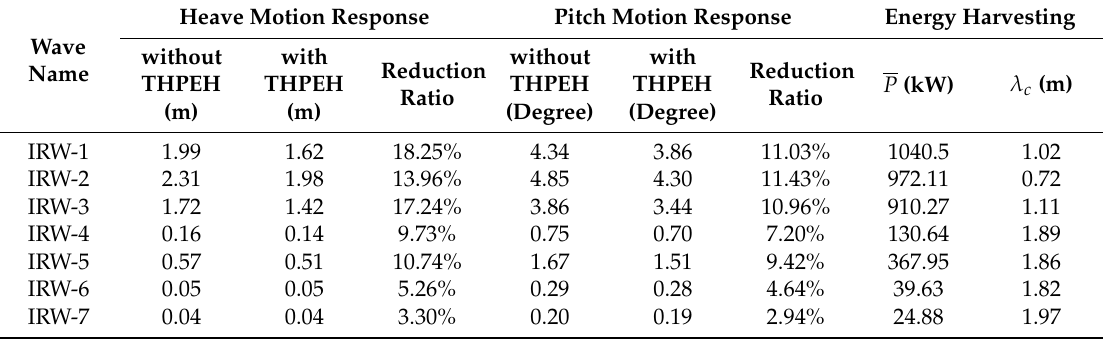
Table 5. Performances of the THPEH system working on the semi-submersible platform under different wave conditions.